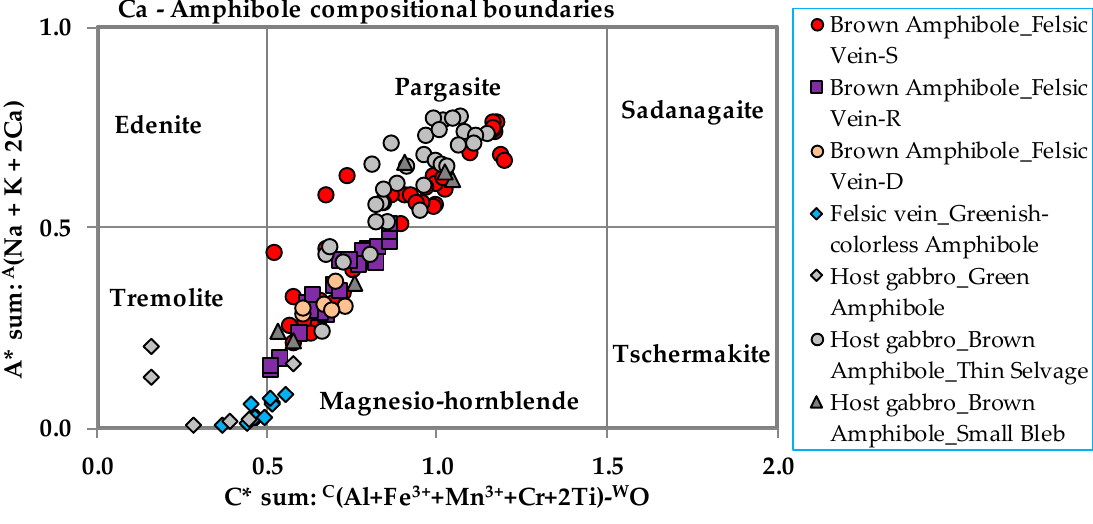
Figure 15. Major and minor element compositions of the amphiboles—Hole U1473A. ( a ) Amphibole Mg# (100 × Mg/(Mg + Fe 2+ ) versus TiO 2 . ( b ) Al 2 O 3 versus SiO 2 . ( c ) Al 2 O 3 versus TiO 2 . ( d ) Al 2 O 3 versus Na 2 O. Symbols are the same as those in Figure 14. Unpublished data from Du Khac Nguyen during Ph.D. course of study at Kanazawa University.